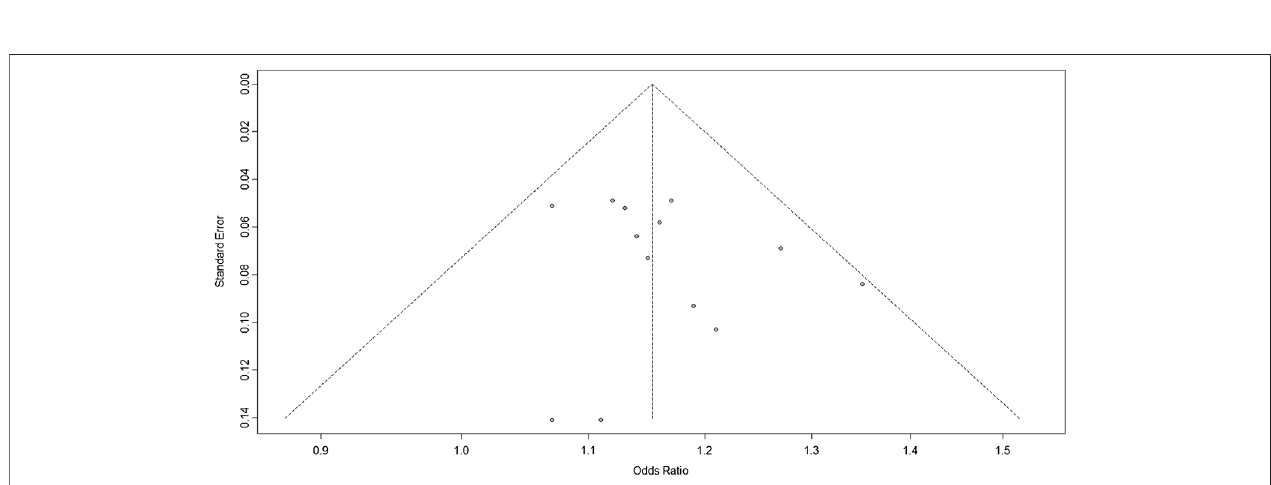
FIGURE 7 | Funnel plots corresponding to the fi xed-effects meta-analysis of the three single-nucleotide polymorphisms (SNPs; rs2383207, rs2383206, and rs10757278) and ischemic stroke (IS) in the third analysis.